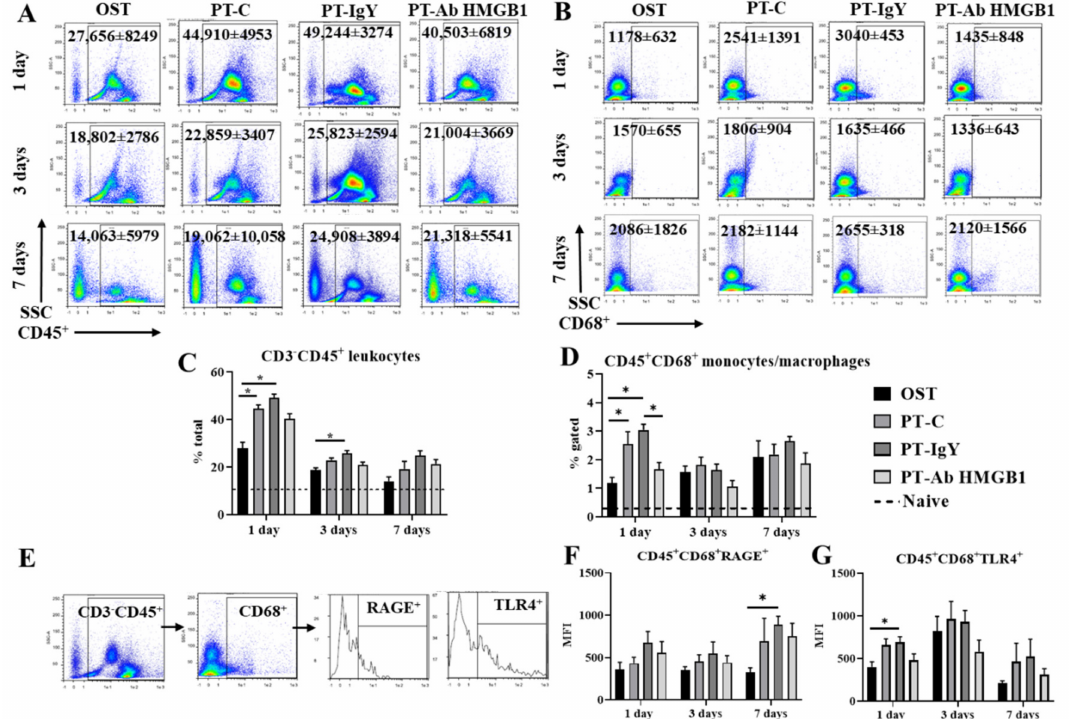
Figure 3. Flow cytometry representative dot plots with mean cell counts ± standard deviation for ( A ) CD45 + leukocytes and ( B ) CD68 + monocytes/macrophages in blood at 1, 3 and 7 days post-trauma (dpt) in osteotomy (OST; n = 10), polytrauma (PT-C; n = 10), polytrauma + IgY (PT-IgY; n = 5 for 1 and 3 dpt; n = 4 for 7 dpt) and polytrauma + anti-HMGB1 antibody (PT- Ab HMGB1; n = 10); ( C ) percentage (%) of CD3 − CD45 + leukocytes; ( D ) % CD45 + CD68 + monocyte/macrophages; ( E ) flow cytometry gating scheme to evaluate RAGE and TLR4 surface expression on CD45 + CD68 + monocytes/macrophages; ( F ) Mean fluorescent intensity (MFI) of CD45 + CD68 + RAGE + monocytes/macrophages; and ( G ) MFI of CD45 + CD68 + TLR4 + monocytes/macrophages in blood from rats with OST, PT-C, PT-IgY and PT-Ab HMGB1 at 1, 3 and 7 days. Naïve uninjured rats were used as baseline controls ( n = 5). The dotted line is the mean of cell counts from naïve rats. * p < 0.05 comparing OST, PT-C, PT-IgY and PT-Ab HMGB1 cohorts. The bar graphs represent mean, whereas error bars represent